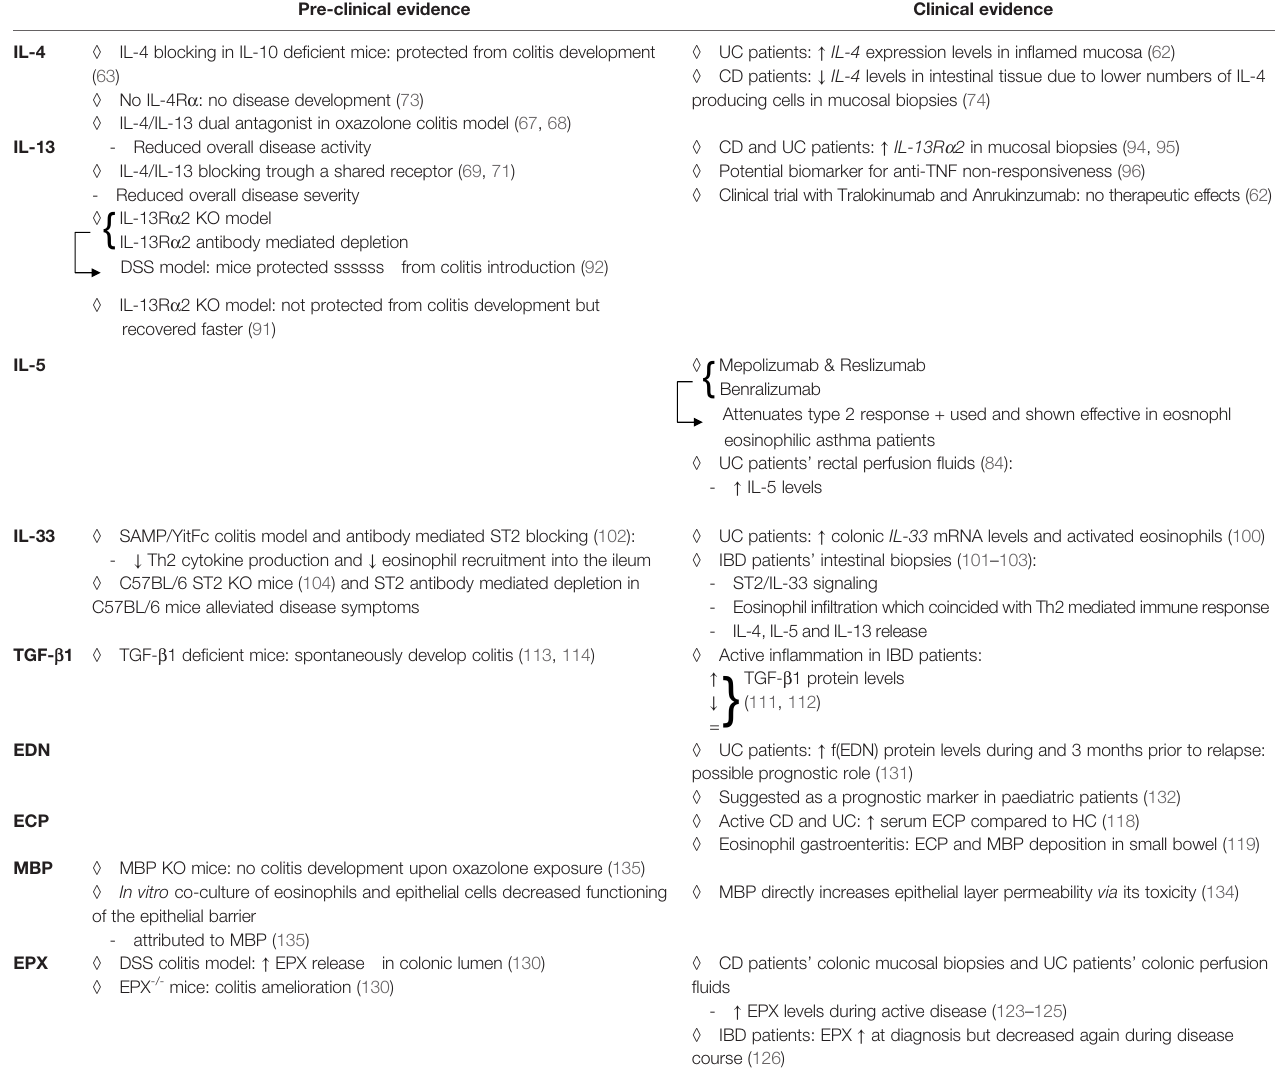
TABLE 1 | Role of eosinophil activating mediators and compounds from eosinophil speci fi c granules in intestinal in fl ammation. Pre-clinical evidence Clinical evidence IL-4